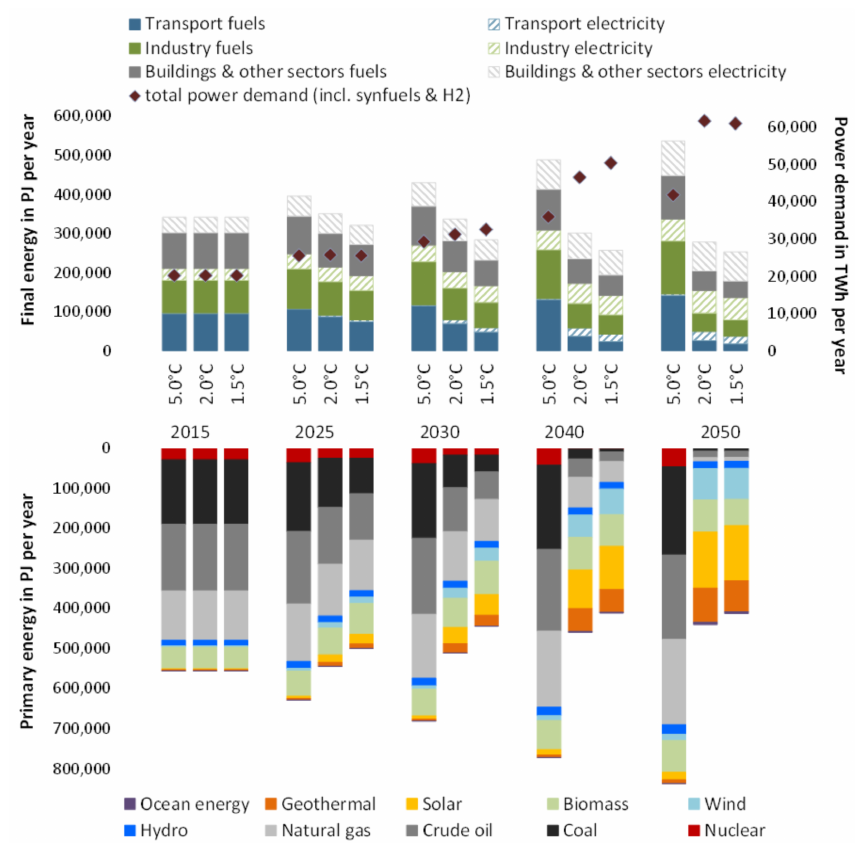
Figure 1. Final energy demand per sector, gross power demand (upper panel), and primary energy supply, including non-energy use (bottom panel), in the